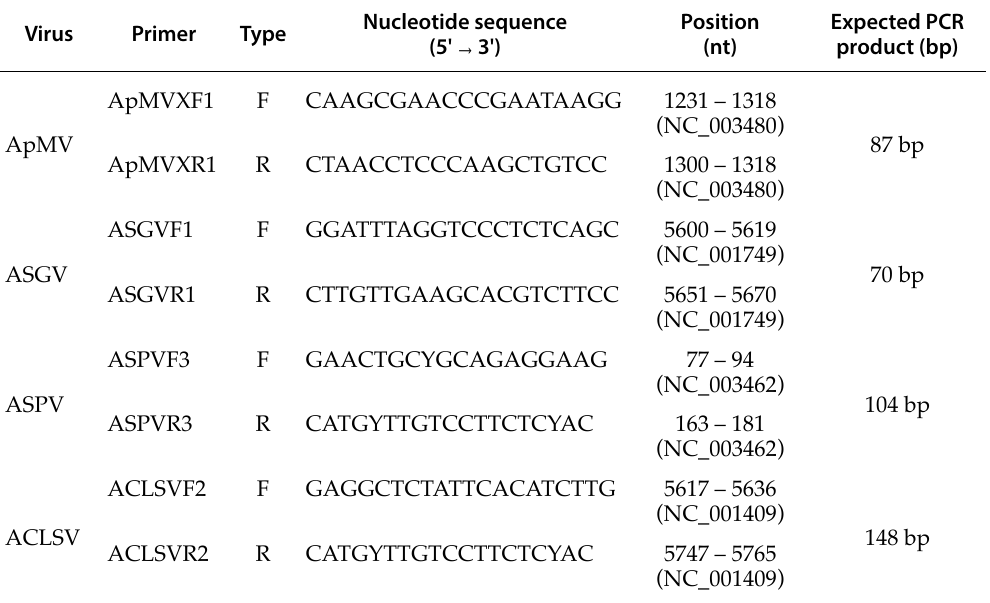
Table 1. Forward (F) and reverse (R) primers used for quantitative real-time RT-PCR detection of the genomic RNA of four pome fruit